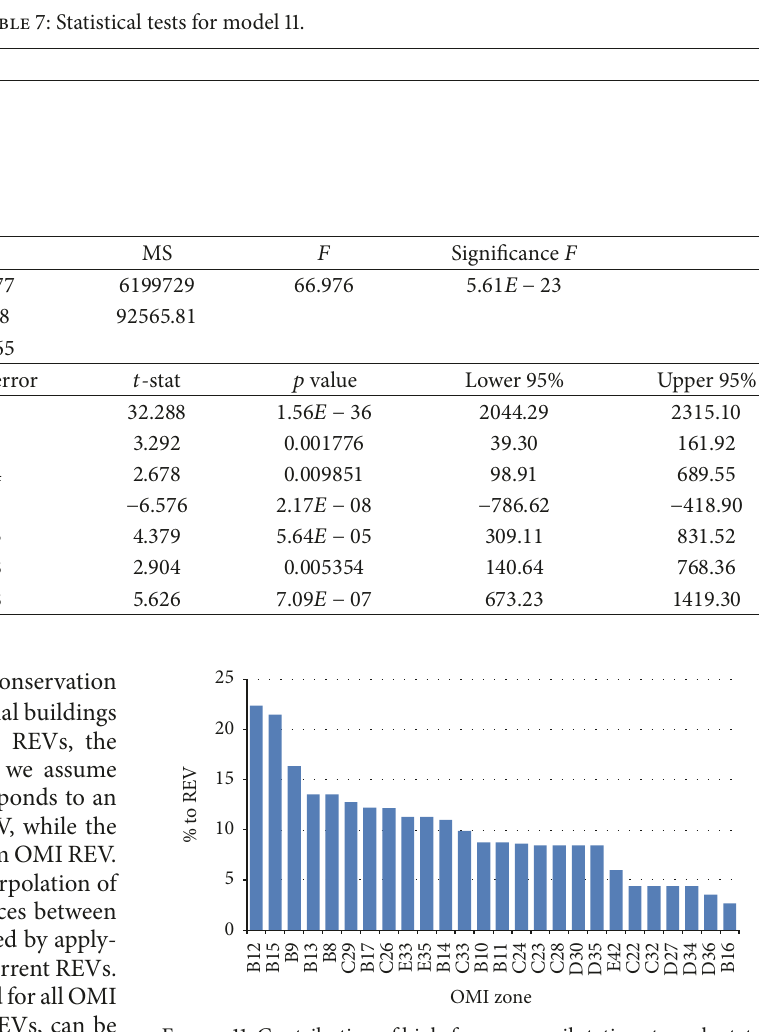
Figure 11: Contribution of high-frequency rail stations to real estate values ( % )